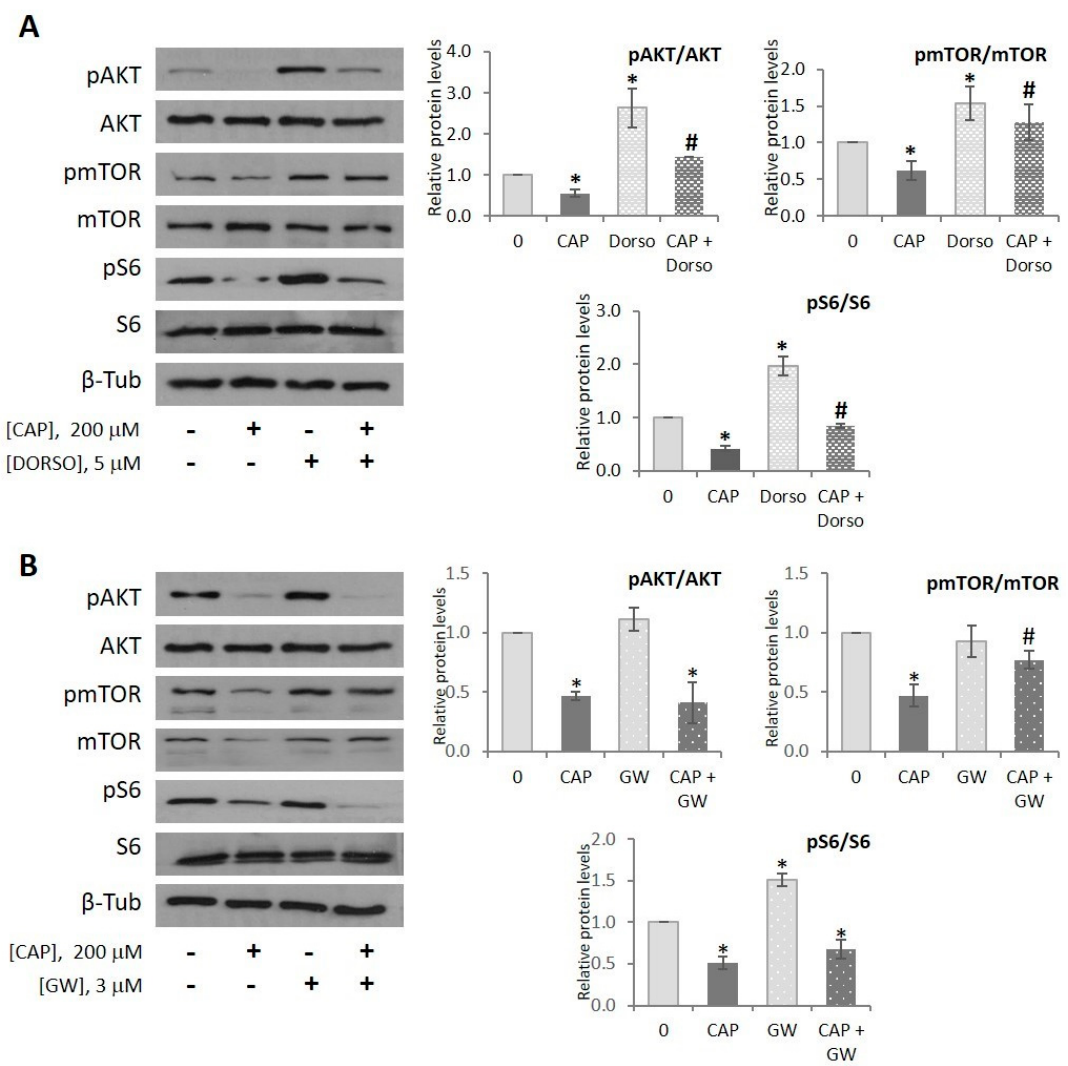
Figure 5. Capsaicin inhibits the AKT/mTORC1 pathway in HepG2 cells. HepG2 cells were cultured in EMEM medium without serum for 24 h. ( A ) Cells were pretreated with vehicle or 5 µ M dorsomorphin (DORSO) for 30 min and treated with or without 200 µ M CAP for 1 h. Cells were lysed and levels of pAKT (Ser473), pmTOR (Ser2448), pS6 (Thr389) and their corresponding total proteins were